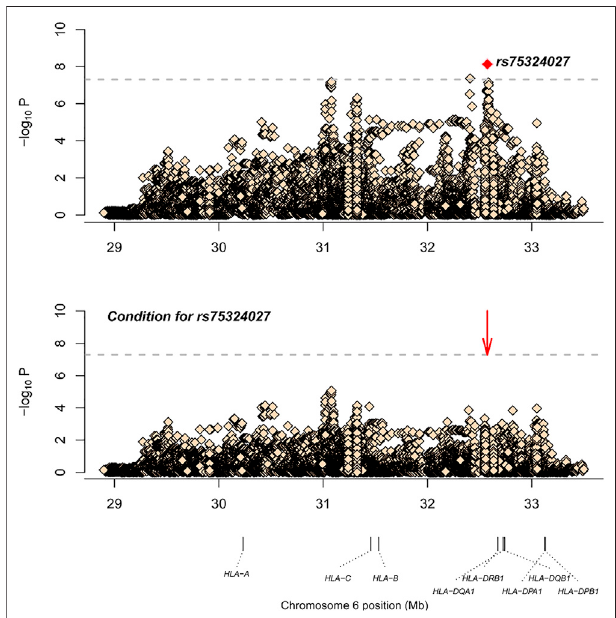
FIGURE 1 | The results of M-S disease association analysis. The abscissa represents genomic loci, and the ordinate represents -log 10 (p) of the association analysis for each locus. The horizontal line represents the signi fi cance threshold p = 1.42 × 10 – 6 . The red dots in each panel represent the sites used for conditional analysis